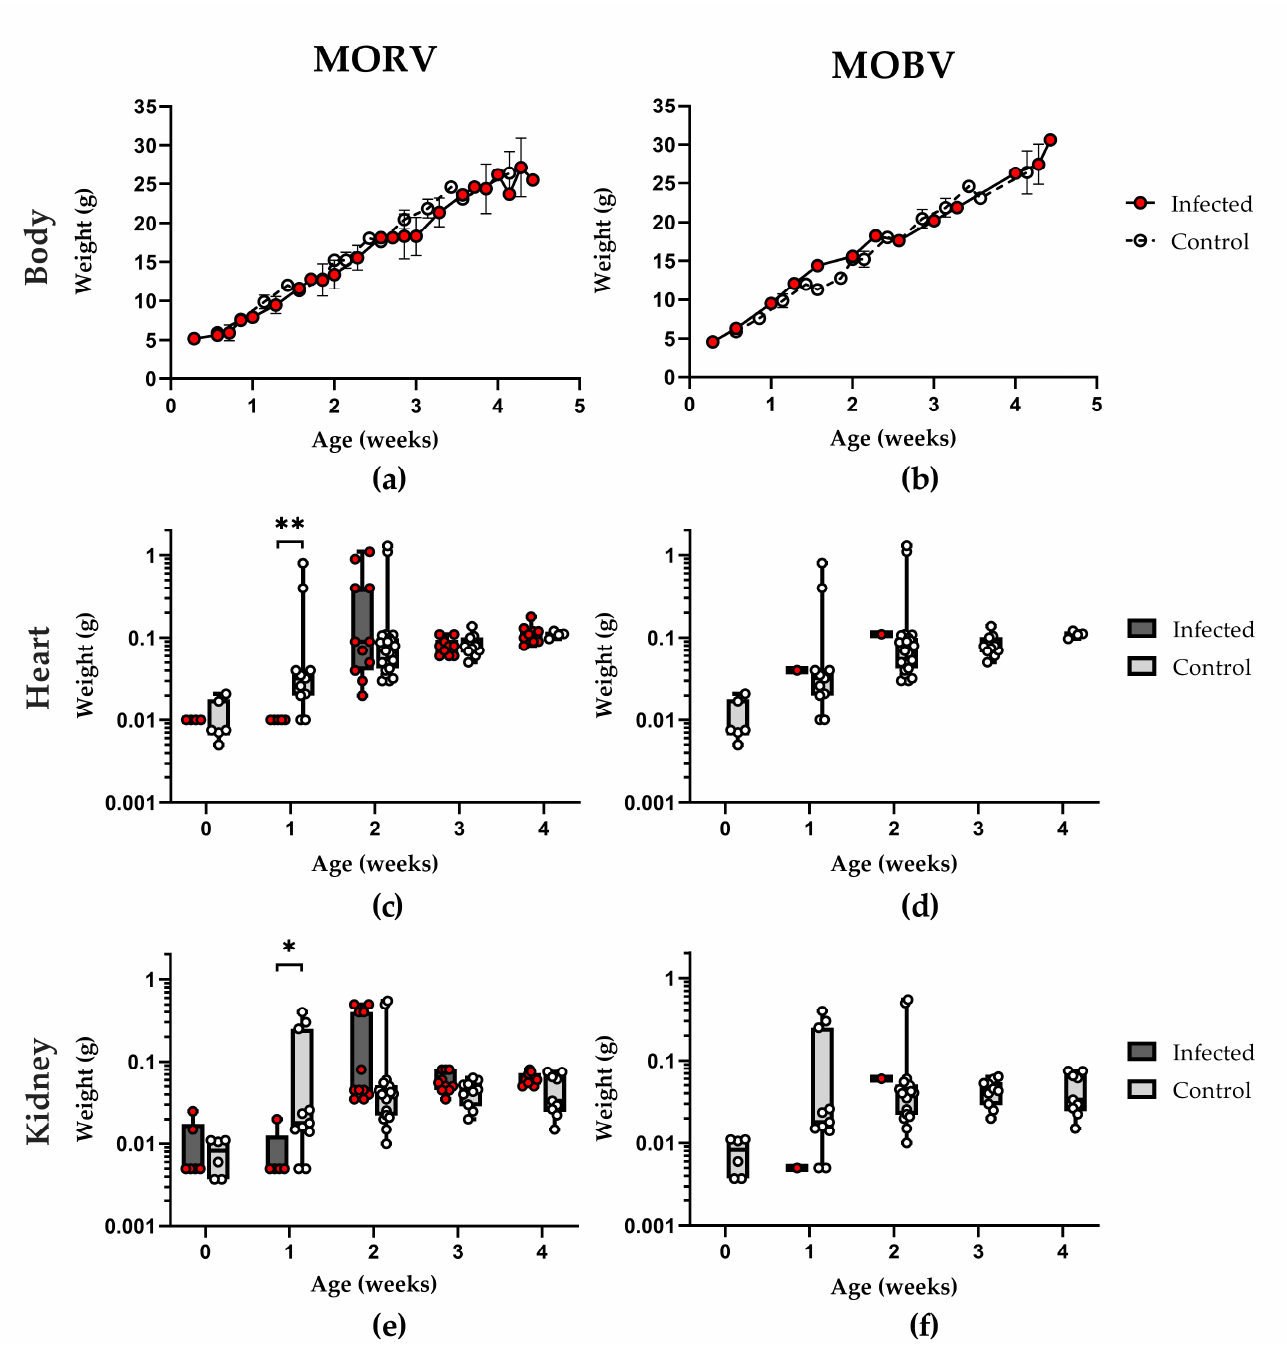
Figure 3. Growth and development of infected Mastomys . Data for the MORV-infected animals (inoculated subcutaneously (s.c.) with 1000 focus forming units (FFU) on days 2, 6, and 14 as well as naturally exposed) are shown on the left, and data for the MOBV-infected animals (inoculated s.c. with 1000 FFU on day 2) are shown on the right. ( a , b ) Body weight, as well as organ weight for hearts ( c , d ) and kidneys ( e , f ) have been measured during the first four (MORV) or two (MOBV) weeks of life. The infected individuals are depicted by red dots, whereas the uninfected control group is depicted by white dots. The body weight is depicted as mean with SD, and organ weights are shown as box and whiskers with all data points plotted. Statistical differences in weight are indicated by * p < 0.05 and ** p < 0.01, as determined by the Mann–Whitney test.